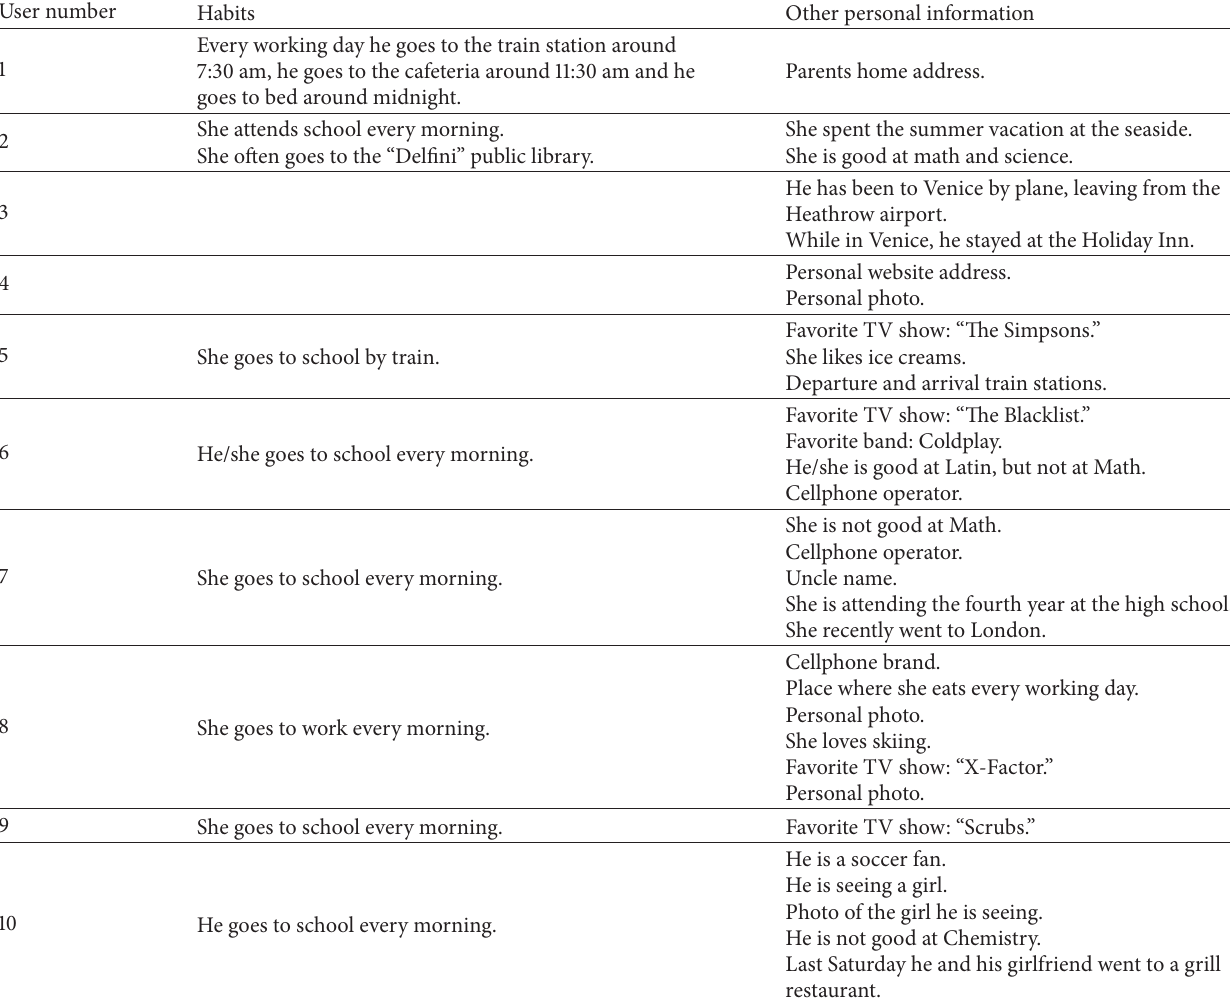
Table 2: User’s habits and personal information retrieved by aggregating the 25 most recent generated